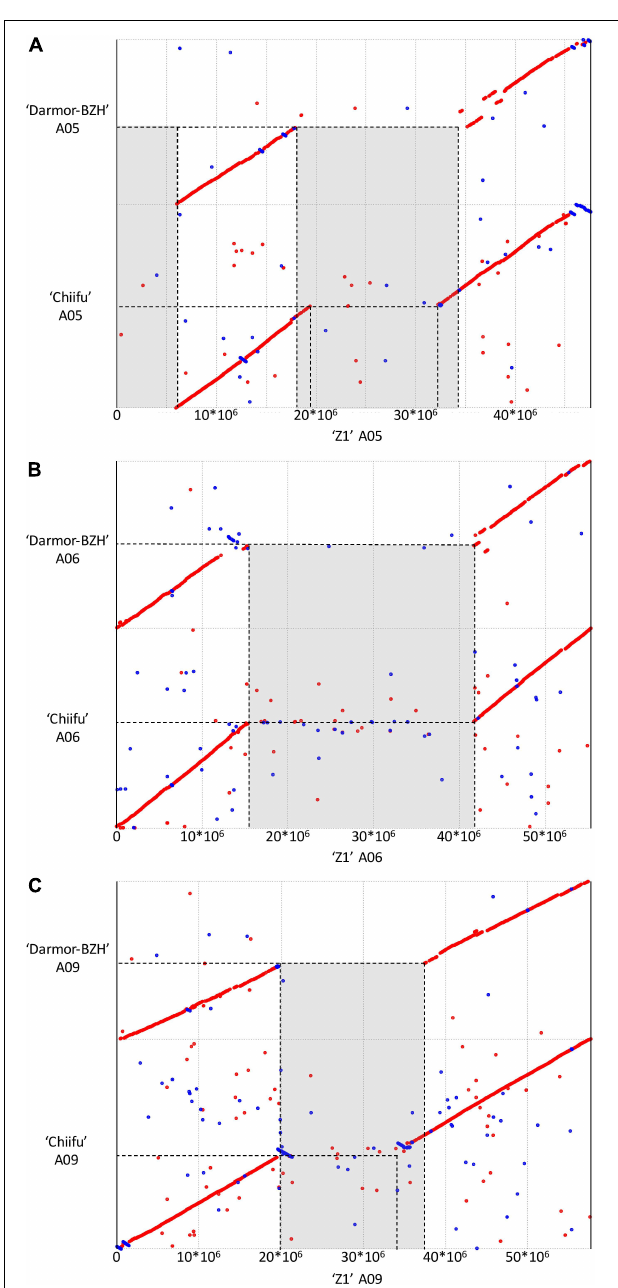
FIGURE 1 | Dot plot comparing the assembly chromosome of B. rapa ‘Z1’ against B. rapa ‘Chiifu’ and B. napus ‘Darmor Bzh’ A subgenome for the chromosomes A05 (A) , A06 (B) , and A09 (C) . Gray boxes corresponded to regions specific to ‘Z1’ genome. Only alignment blocks with greater than 95% of identity and a length greater than 4,000 bp were